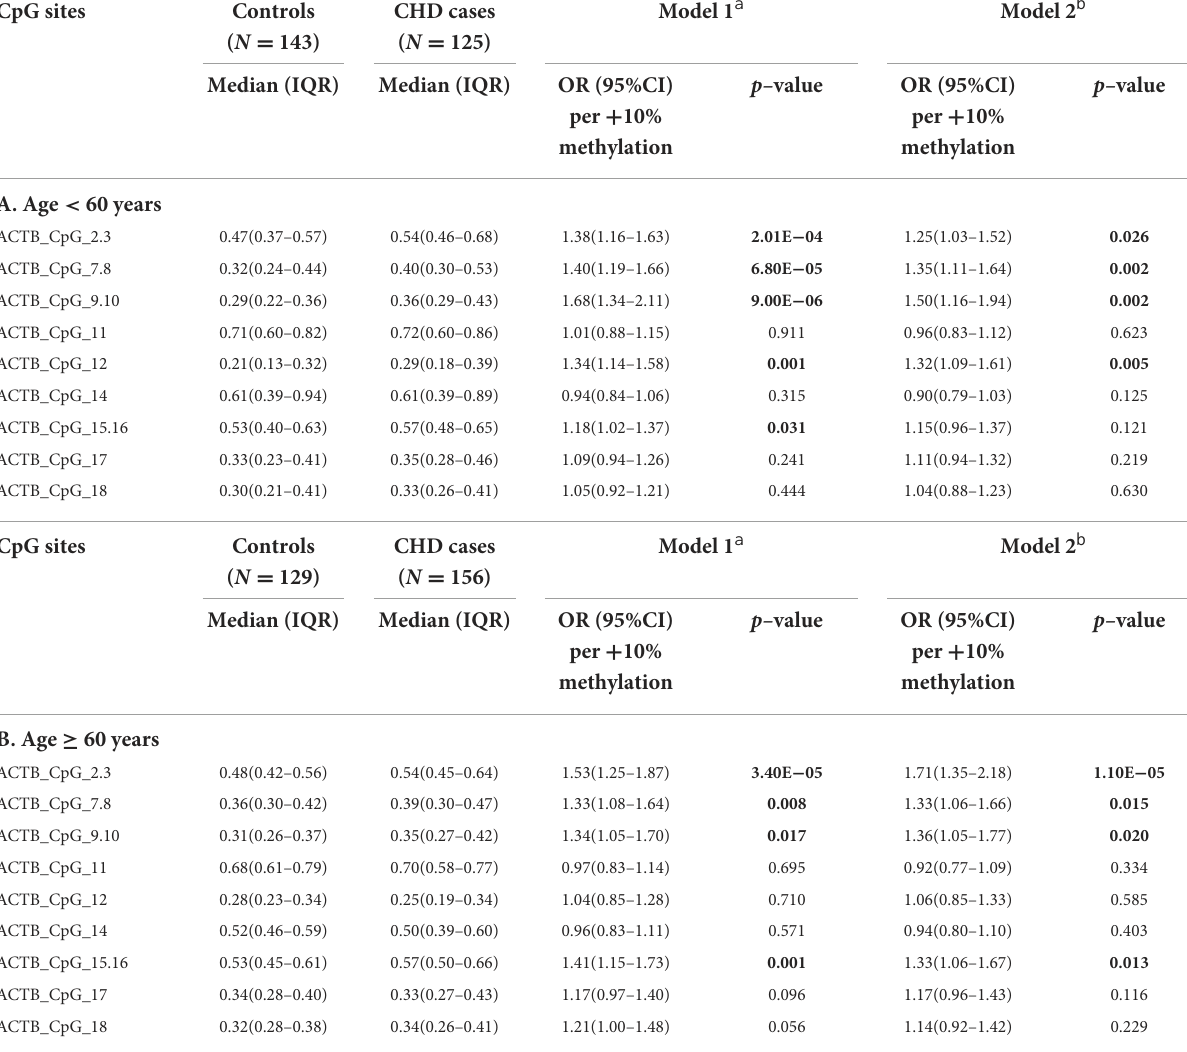
TABLE 4 Age–specific methylation difference of ACTB between CHD cases and